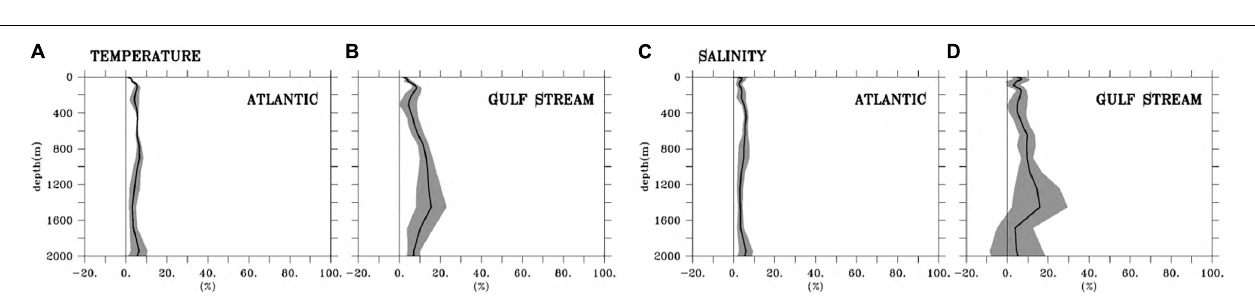
FIGURE 4 | Temperature (A) and salinity (B) RMSE with respect to the NR for the period January 2009 to June 2009, area-averaged in the Atlantic Ocean, from MOI (black), the Met-Office (blue), the CLS (gray), and the CMCC (red) systems.